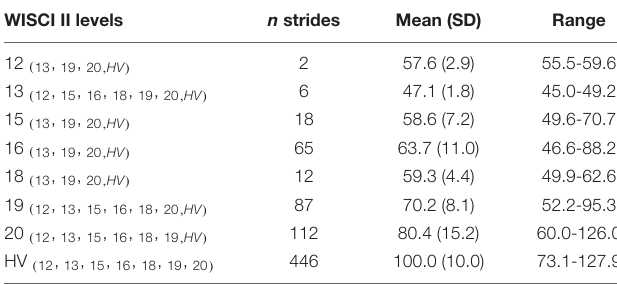
TABLE 3 | Descriptive statistics of GDI values (mean and range) within each WISCI II level. WISCI II